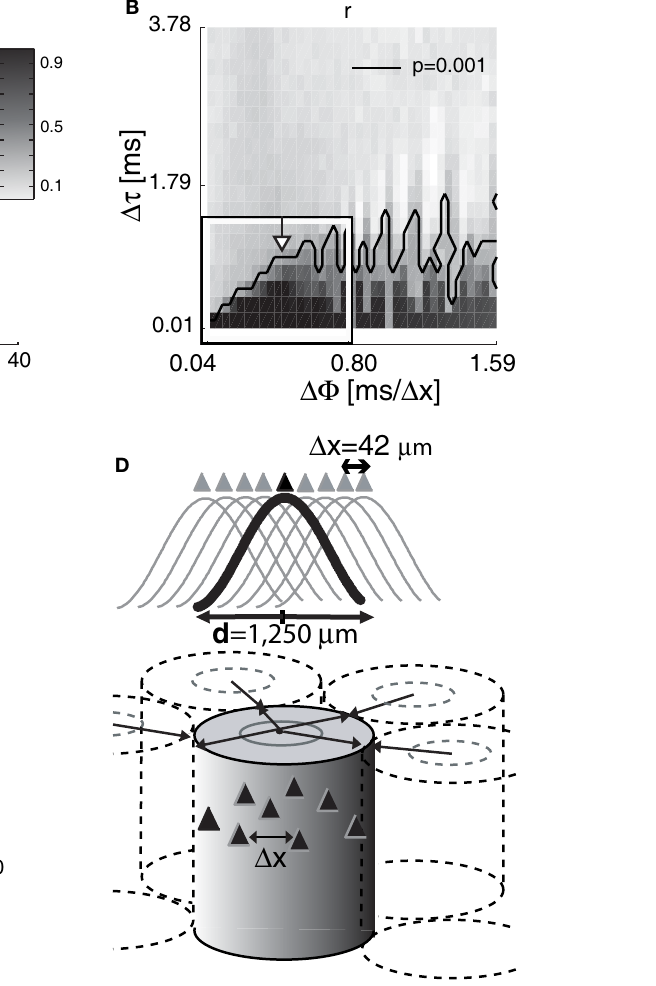
of ΔΦ = 0–0.8 and Δτ = 0.01–1.52 ms [the rectangular area in (B) ] revealed the optimum phase gradient ΔΦ = 0.4. The contour line represents the P = 0.001 confi dence limit. (D) Estimating the cortical area of precise reconstruction. Given Δ x ≈ 42 µm average nearest-neuron distance and ΔΦ ≈ 0.4 ms at gamma frequency (from B–C ), we extrapolate d ≈ 1,250 µm as the diameter of a cylindrical cortical volume comprising a neuron population necessary and suffi cient to reconstruct the complete information transferred within a single gamma cycle. Filled triangles represent neurons, cosine functions represent phases of a spreading gamma wave and arrows represent radial propagation of gamma